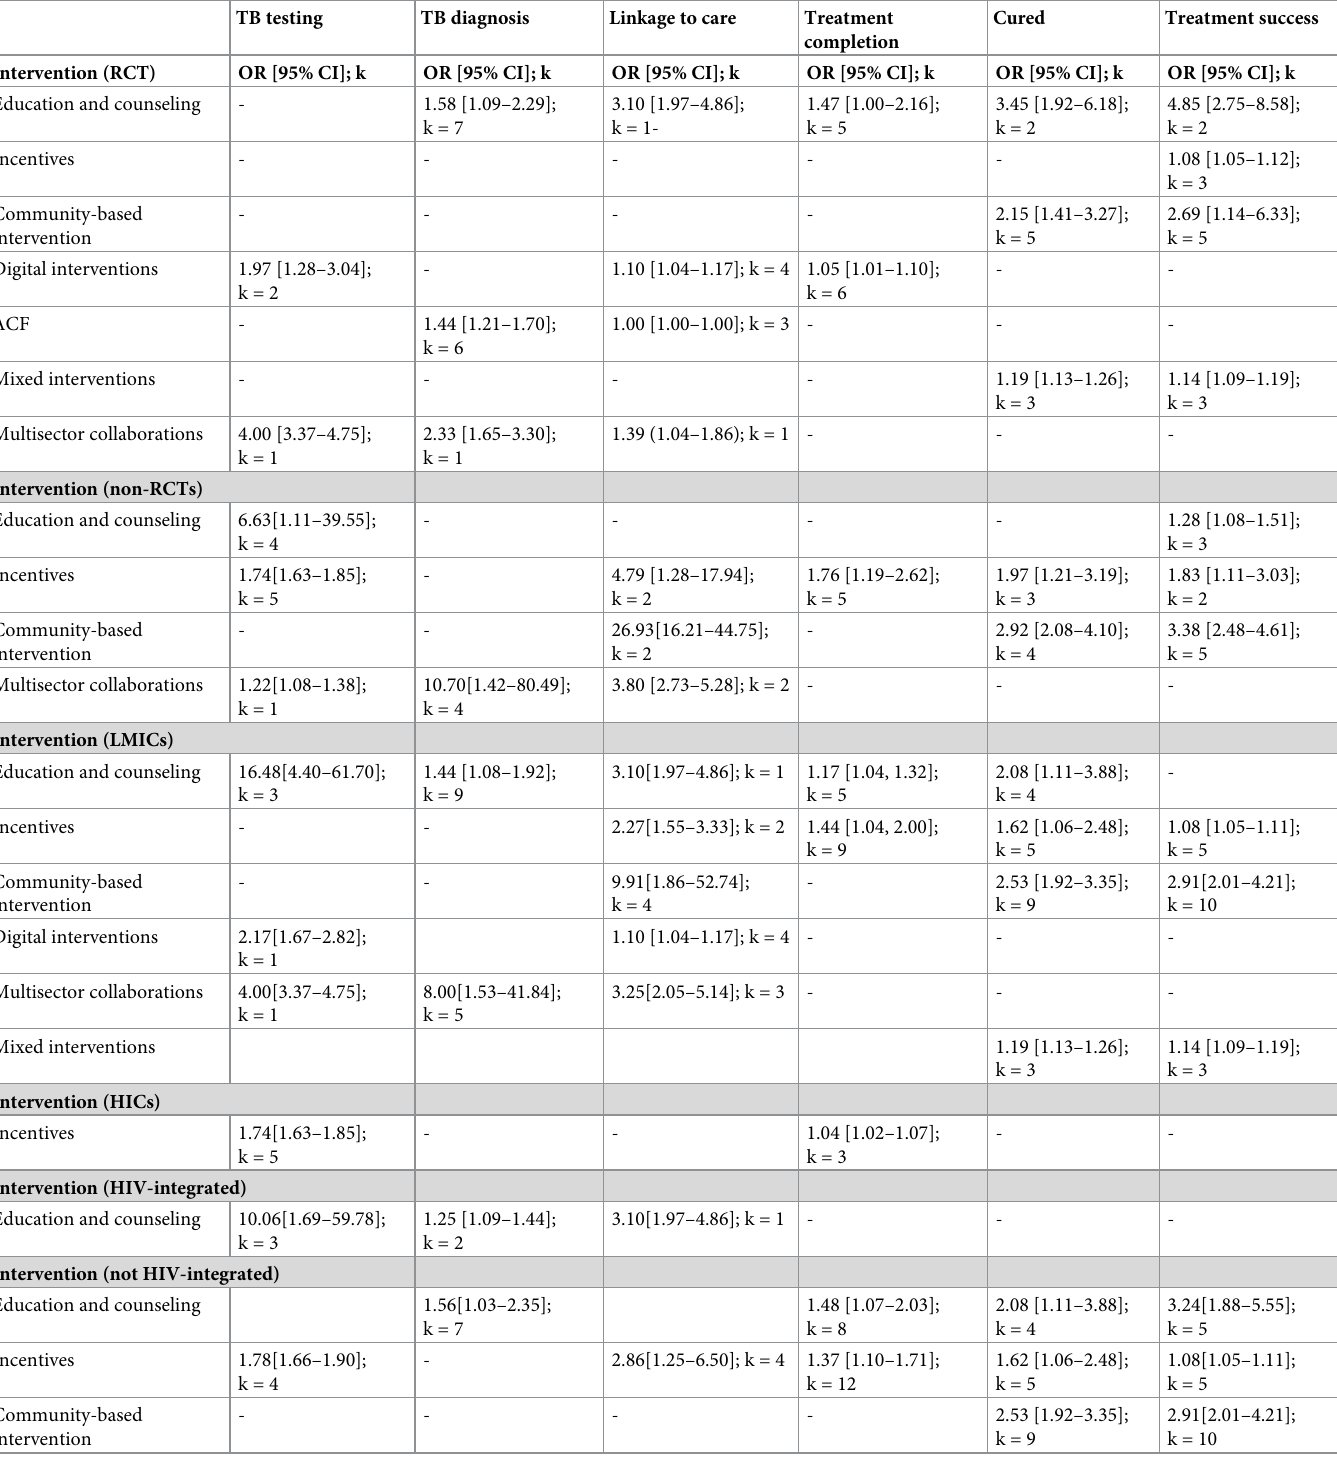
Table 5. Interventions significantly associated with TB care outcomes at multiple stages of the TB care cascade stratified by